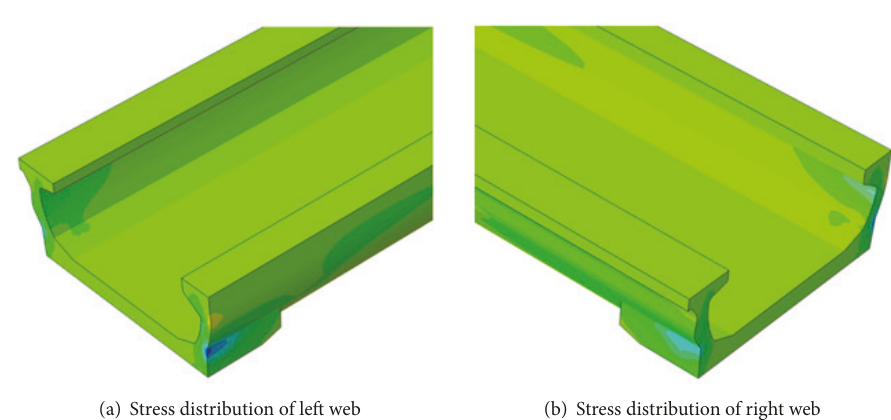
Figure 11: Stress-strain relationship of steels.